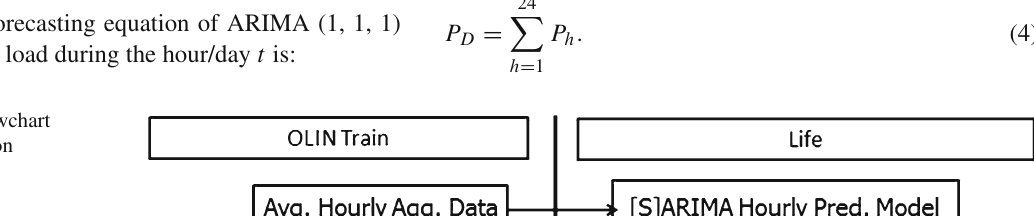
Fig. 2 SWH[2]SA flowchart algorithm